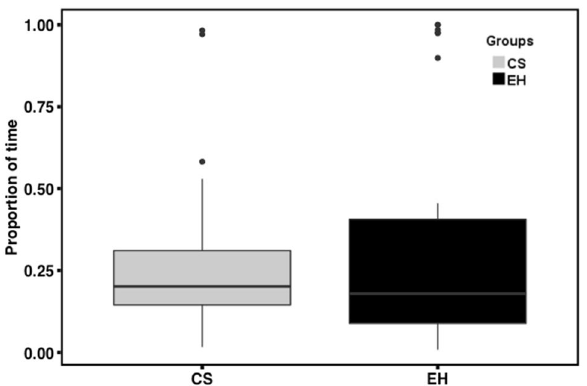
Figure 3. The proportion of time spent nearby novel object between groups. The solid line indicates the median. The bottom of the box represents the first quartile (25th percentile) and the top of the box represents the third quartile (75th percentile). Whiskers represent the lower and upper bound for data excluding